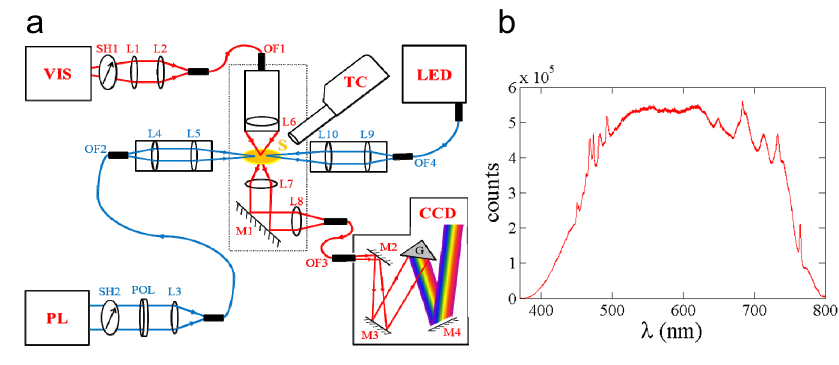
Figure 2. ( a ) Components of the microspectrophotometer. VIS: cw-Xenon light source; PL: pulsed laser; TC: temperature control; LED: high power light emitting diode; CCD: image intensified camera to record spectra; S: sample; OFx: optical fibers; Lx: lenses; Mx: mirrors; SHx: shutters; POL: polarizer; G: grating; ( b ) Spectrum of the Xenon light source used for optical